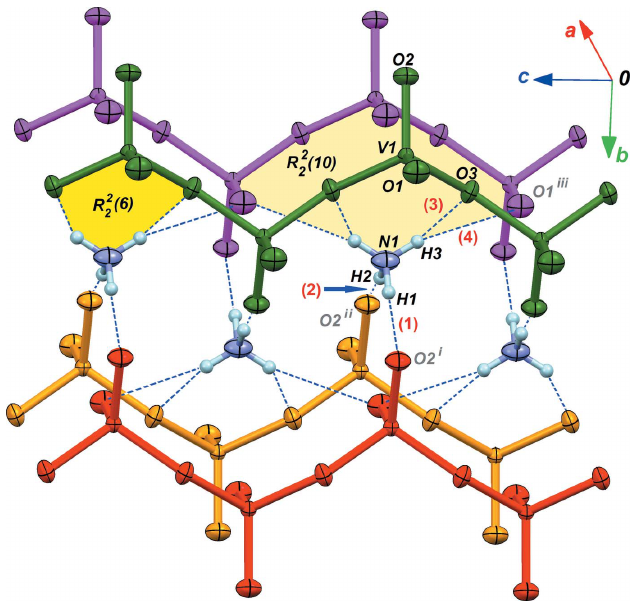
Figure 2 Part of the crystal structure of ammonium metavanadate, showing hydrogen bonds as dashed lines. Four vanadate chains are represented with different colours, and the asymmetric unit is indicated with black labels. Hydrogen bonds are labelled (1)–(4), corresponding to entries in Table 2, and the supramolecular rings linking the anions and cations in the crystal are coloured yellow. Displacement ellipsoids are drawn at the (cid:4) y , (cid:4) z and x , y , 1 (cid:4) z , 50% probability level. [Symmetry codes: (i) (cid:4) x + 1, y + 1 , (cid:4) z + 1 ; (ii) 2 2 2 2 (cid:4) x + 2, y + 1 , (cid:4) z + 1 ; (iii) x + 1, (cid:4) y + 1 , (cid:4) z 2 2 2